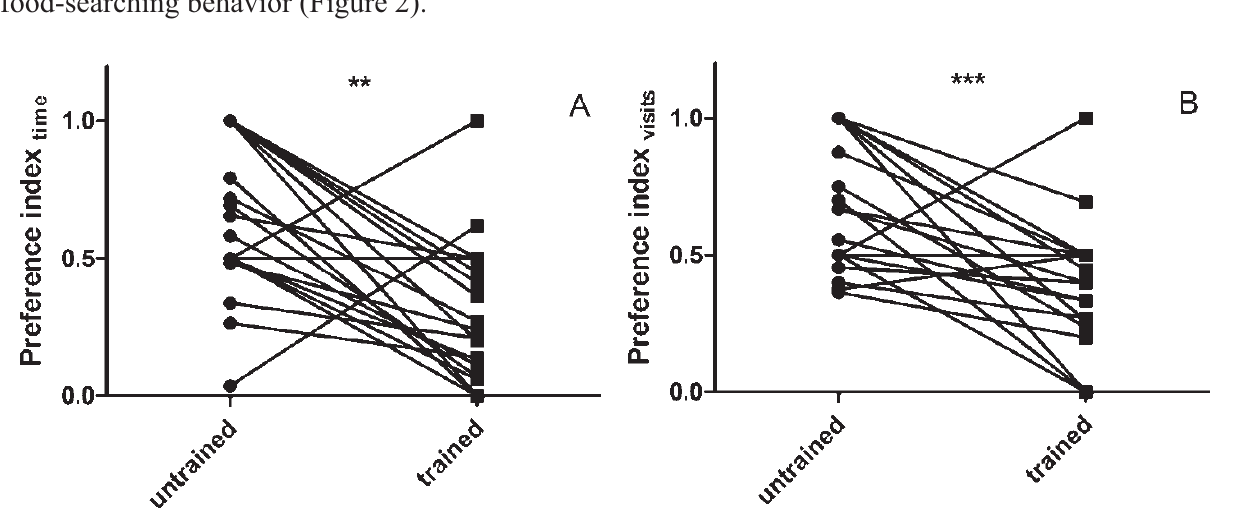
Figure 2. The effect of training on color-dependent foraging behavior, as assayed in the training arena. Untrained animals generally preferred the yellow cage (Pref > 0.5). Overnight training significantly reduced both the time spent in the yellow cage ( A ) as the relative number of visits to this cage ( B ). Data represent paired measurements before and after training ( n = 25). Results were analysed using the Wilcoxon signed rank test. ** p <0.01, *** p